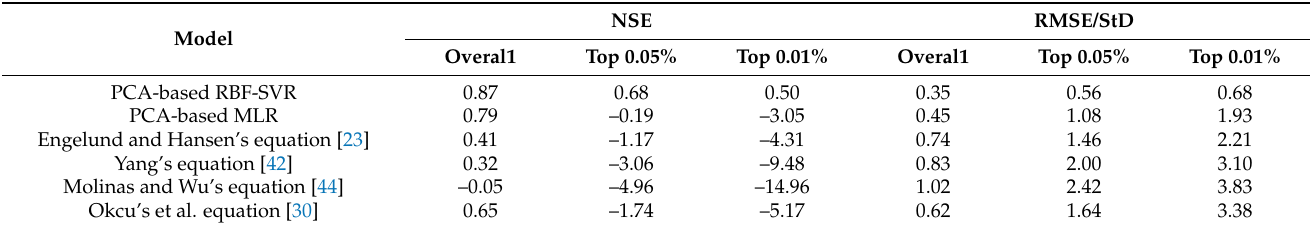
Table 3. Comparison between the performance of PCA-based MLR and PCA-based RBF-SVR models and the well-established empirical equations for sediment concentration estimation.